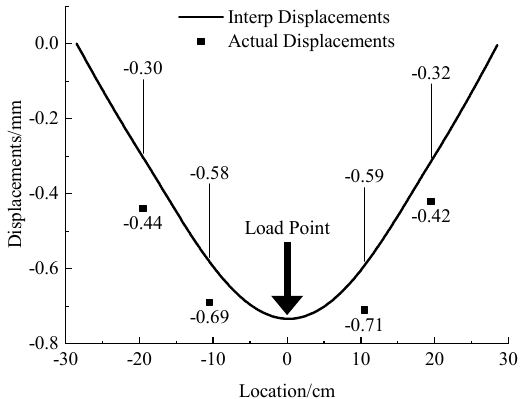
Figure 10. Deformation curve and measured displacement of orthogonal acrylic tunnel with 1 mm+1 mm thickness under concentrated load.